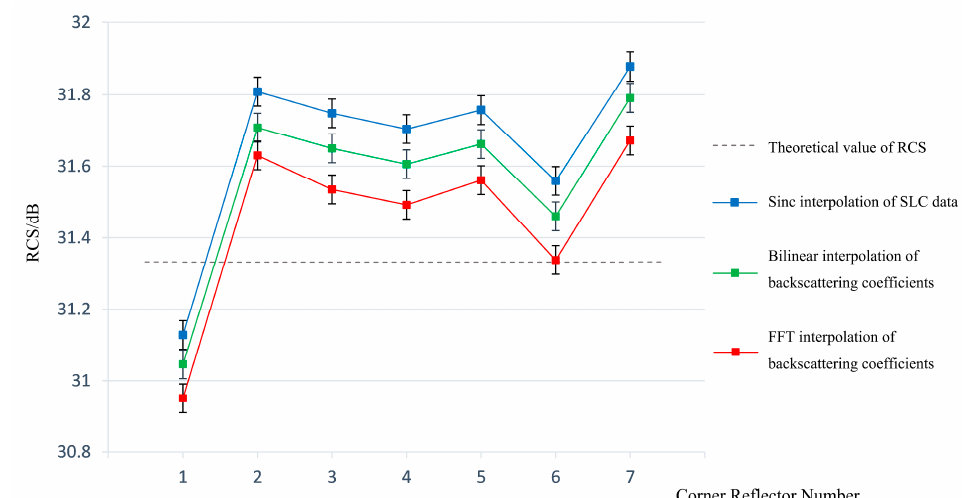
Figure 9. The extracted RCS values of each corner reflector using Sinc, Bilinear and FFT interpolation methods.